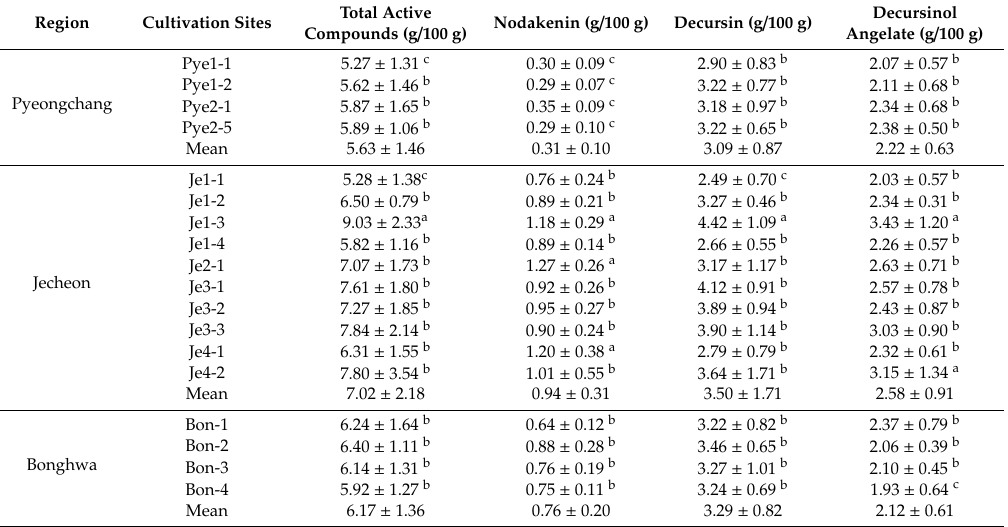
Table 6. Active compounds in root extracts of Angelica gigas Nakai cultivation sites, Korea (mean ± SD).